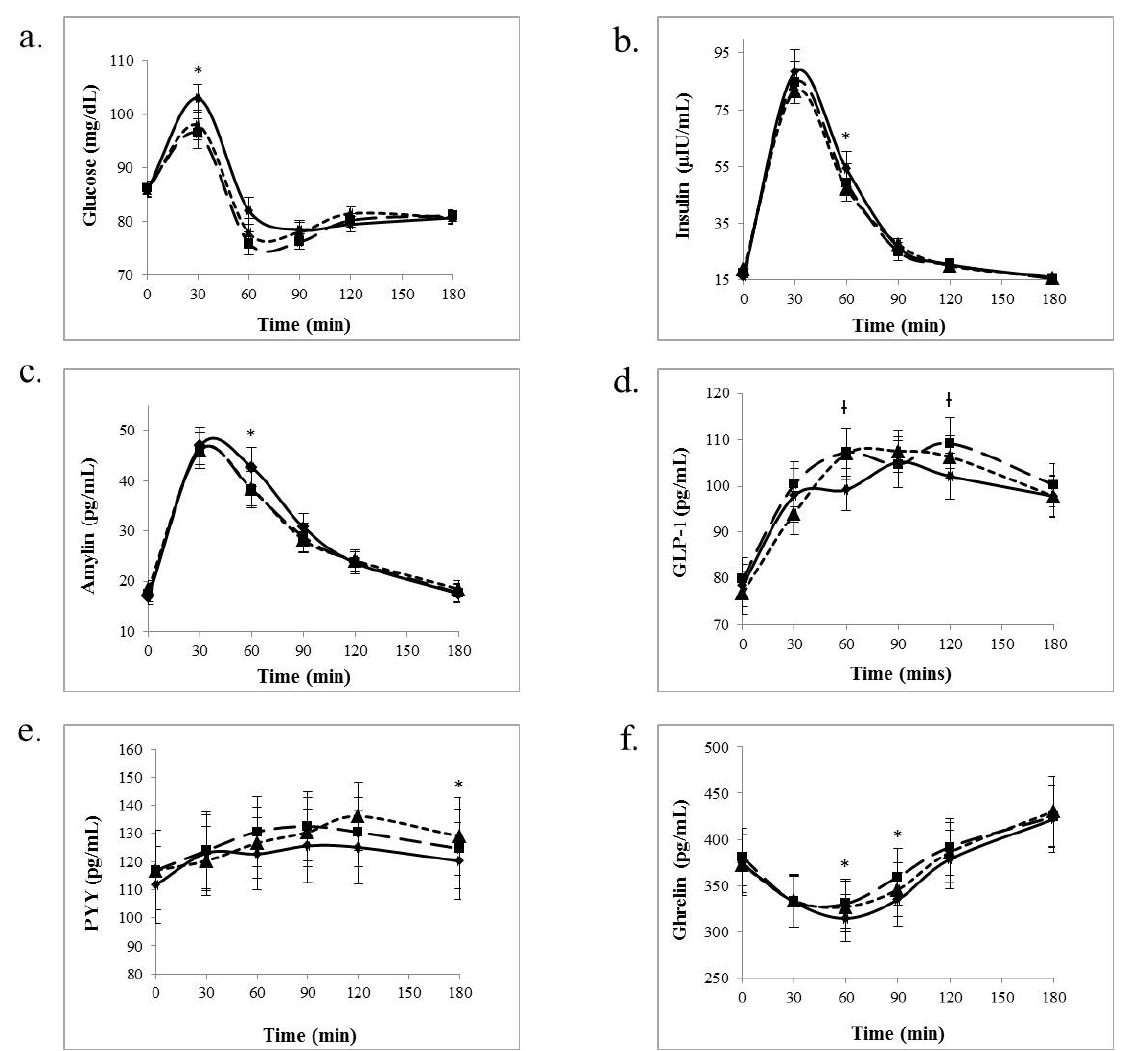
Figure A1. Serum glucose (a), insulin (b), amylin (c), GLP-1 (d), PYY (e) and ghrelin (f) levels during Figure A1. Serum glucose ( a ), insulin ( b ), amylin ( c ), GLP-1 ( d ), PYY ( e ) and ghrelin ( f ) levels during Figure 2. Visual analogue scales (VAS) scores for hunger (a), fullness (b), satiety (c), and prospective Figure 2. Visual analogue scales (VAS) scores for hunger (a), fullness (b), satiety (c), and prospective Figure 2. Visual analogue scales (VAS) scores for hunger (a), fullness (b), satiety (c), and prospective 3 h after the mixed breakfast meal with a dose of SC or placebo. Abbreviations: glucagon-like peptide- 3 h after the mixed breakfast meal with a dose of SC or placebo. Abbreviations: glucagon-like peptide-1 food consumption (d) during 3 h after the mixed breakfast meal with a dose of Salacia Chinensis (SC) food consumption (d) during 3 h after the mixed breakfast meal with a dose of Salacia Chinensis (SC) food consumption (d) during 3 h after the mixed breakfast meal with a dose of Salacia Chinensis (SC) 1 (GLP-1), peptide YY (PYY), Salacia Chinensis extract (SC). * p < 0.05; ƚ p < 0.06, Differs from placebo. (GLP-1), peptide YY (PYY), Salacia Chinensis extract (SC). * p < 0.05; l p < 0.06, Differs from placebo. or placebo ( n = 48). * p < 0.05, Differs compared to placebo. Values are means ± standard error of the or placebo ( n = 48). * p < 0.05, Differs compared to placebo. Values are means ± standard error of the or placebo ( n = 48). * p < 0.05, Differs compared to placebo. Values are means ± standard error of the Values are means ± SEM. Placebo: ; 300 mg: ; 500 mg: mean (SEM). Placebo: ; 300 mg: ; 500 mg: mean (SEM). Placebo: ; 300 mg: ; 500 mg: mean (SEM). Placebo: ; 300 mg: Values are means ± SEM. Placebo: ; 500 mg: